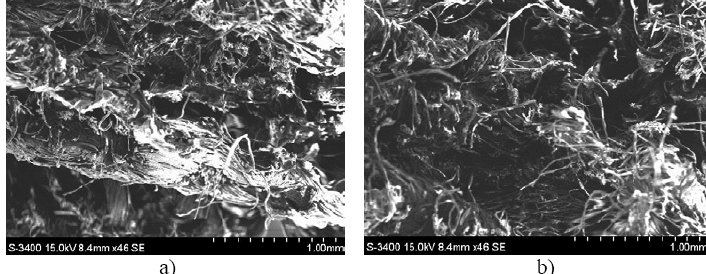
Figure 13. Image of the breaking area for a representative sample of the set of composite materials with matrix of hybrid resin of type 2 and reinforcing material of the first type of flax fabric ( a ), respectively second type of flax fabric ( b